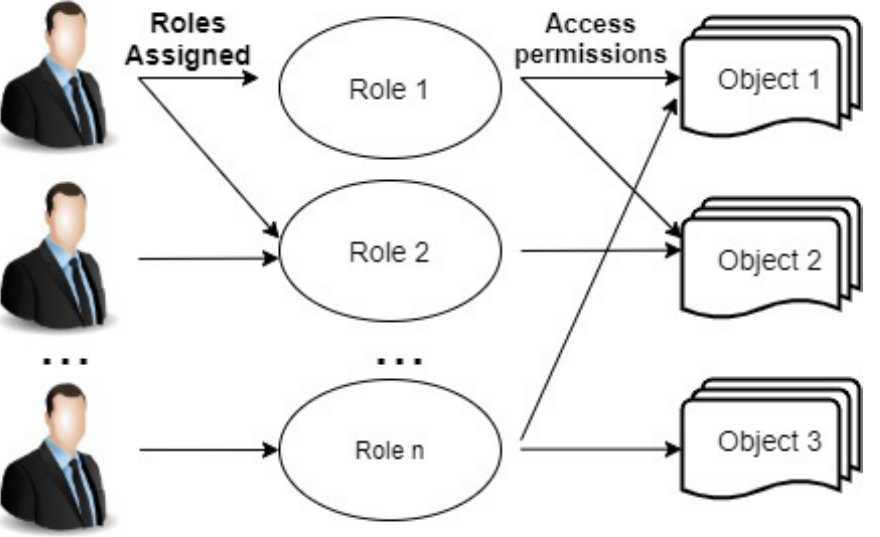
Figure 4. Basic concept of Role-Based Access